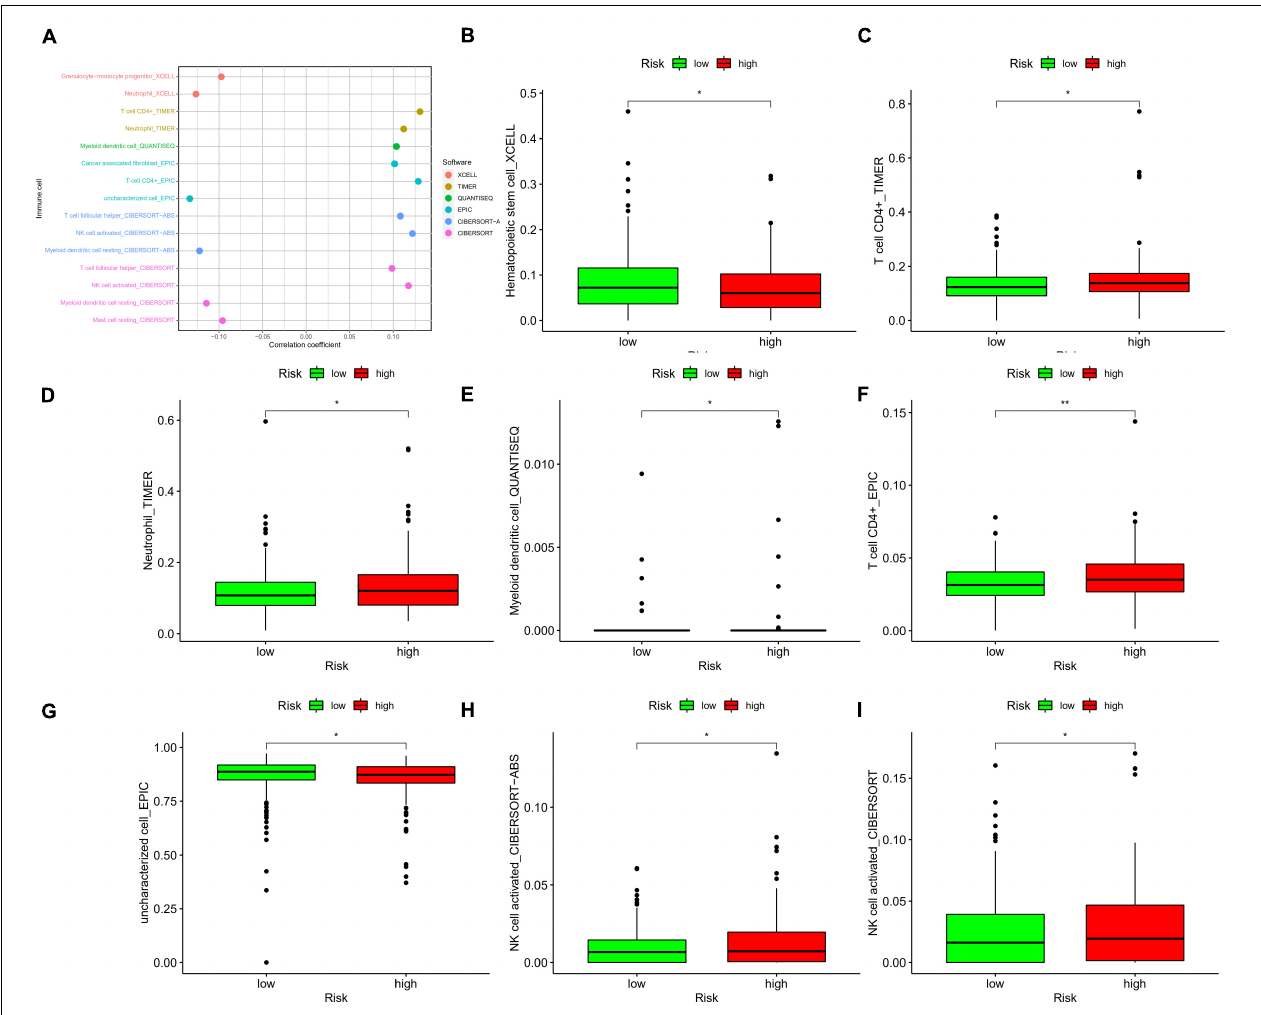
FIGURE 8 | (A) The risk score correlated with the presence of many kinds of immune cells, including granulocyte-monocyte progenitors, neutrophils, CD4+ T cells, myeloid dendritic cells, cancer-associated fibroblasts, and activated NK cells, among others. A high risk score was positively associated with the presence of tumor infiltrating immune cells, including CD4+ T cells (C,F) , neutrophils (D) , and activated NK cells (H,I) , as well as was negatively associated with the presence of hematopoietic stem cells (B) , myeloid dendritic cells (E) , and uncharacterized cells (G) . * p < 0.05; ** p <